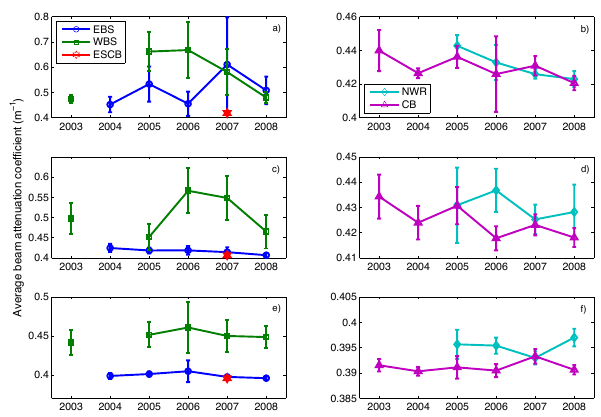
Fig. 13. The average attenuation within the five different regions - the eastern Beaufort shelf (EBS), the western Beaufort shelf (WBS), the eastern shelf of the Canada Basin (ESCB), the eastern slope of the Northwind Ridge (NWR) and the interior of the Canada Basin (CB). The error bars represent the standard error. The average at- tenuation was plotted for shelf stations EBS, WBS and ESCB ( a, c and e ) and basin stations NWR and CB ( b, d and f ). To understand how attenuation varied with depth, the average was calculated for a and b) 1–25m, c and d) 26–100m, and e) 101–500m for the shelf stations and f) 101–900m for NWR and 101–3500m for